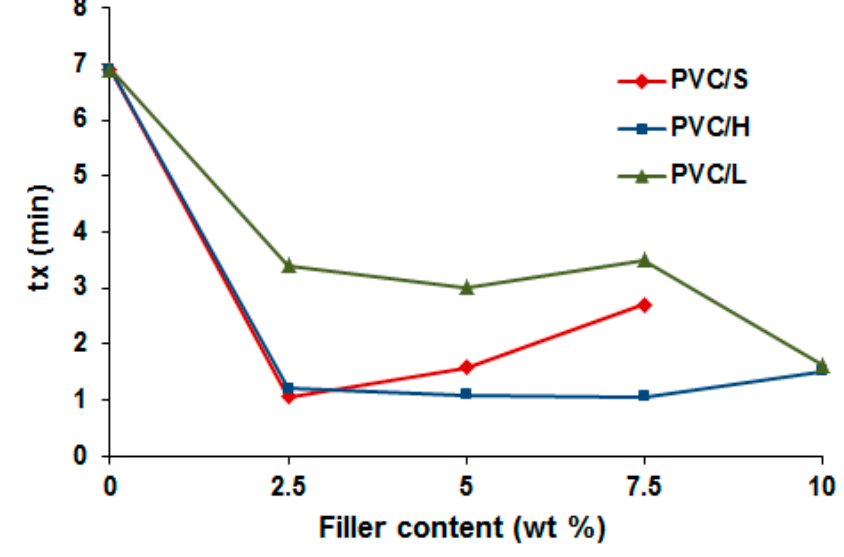
Figure 3. Time to reach the maximum value of torque ( t a function of filler content.